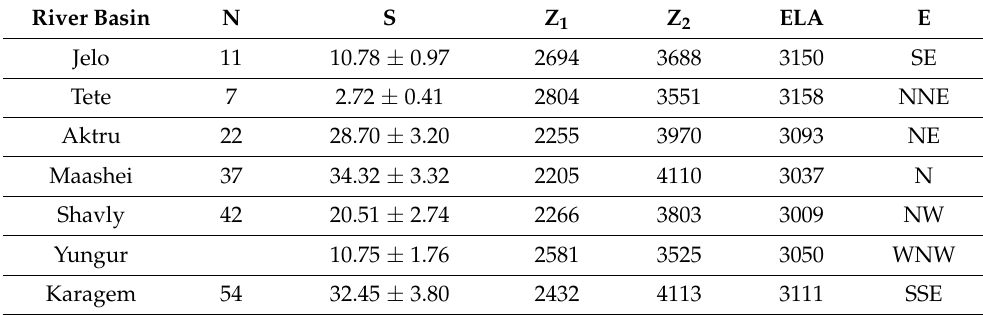
Table 6. Glaciers of the North-Chuya ridge in 2000. Abbreviations are given in Table 5. River Basin